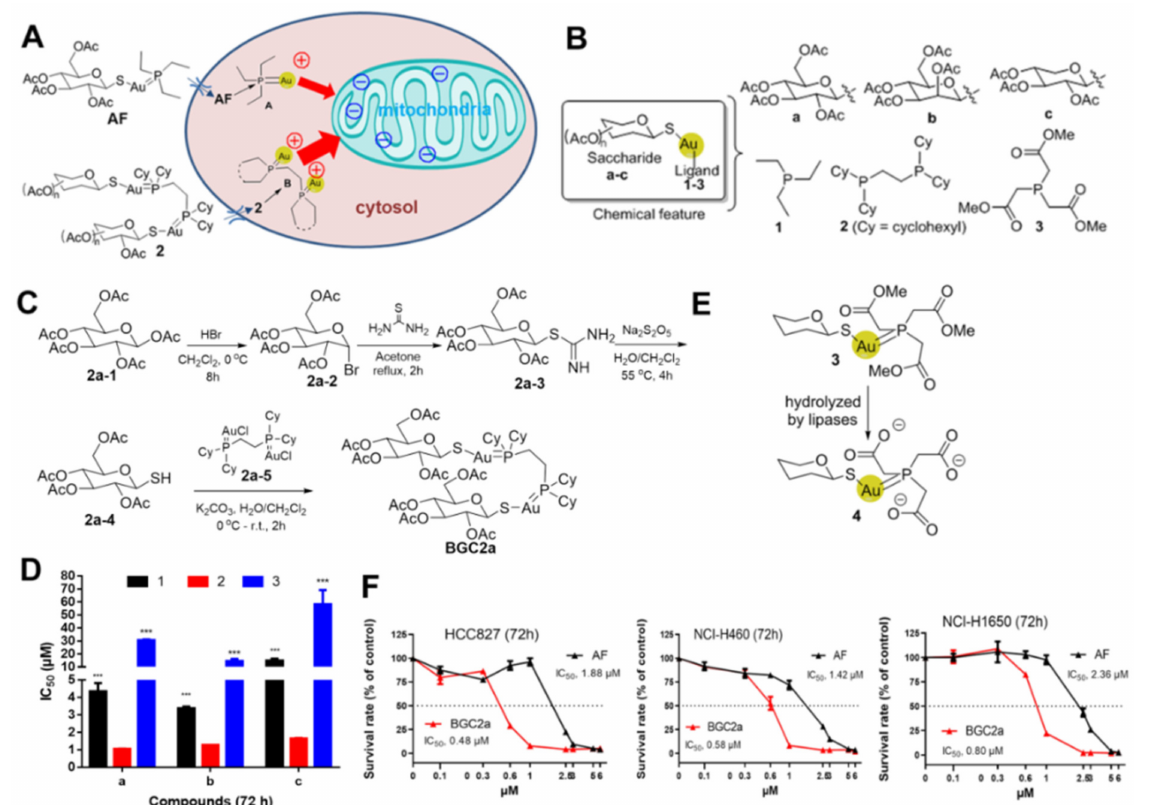
Figure 1. Auranofin (AF), the designed bi-gold compound BGC2a and their antiproliferation effects on lung cancer cells. ( A ) Our hypothesized action model: targeting mitochondria by gold compounds with different degrees of positive charges. ( B ) The designed gold compounds with various saccharide thiols (a–c) and phosphine ligands (1–3). ( C ) Synthetic route of BGC2a. Note: Cy means cyclohexyl. ( D ) IC 50 values of different gold-containing compounds against A549 lung cancer cells after a 72 h treatment. Series 2 bi-gold compounds exhibited much lower IC 50 values compared to both series 1 compounds and series 3 compounds. IC 50 values were calculated by GraphPad Prism 7 for their half response to inhibit cell proliferation. (***) p < 0.001 vs. series 2. ( E ) The proposed intracellular hydrolysis of compound 3 to become negative-charged compound 4. ( F ) The antiproliferation activities of BGC2a and AF in three other lung cancer cell lines HCC827, NCI,-H460 and